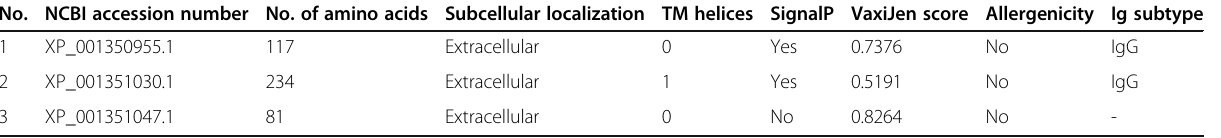
Table 1 Characteristics of 3 selected extracellular hypothetical proteins of Plasmodium